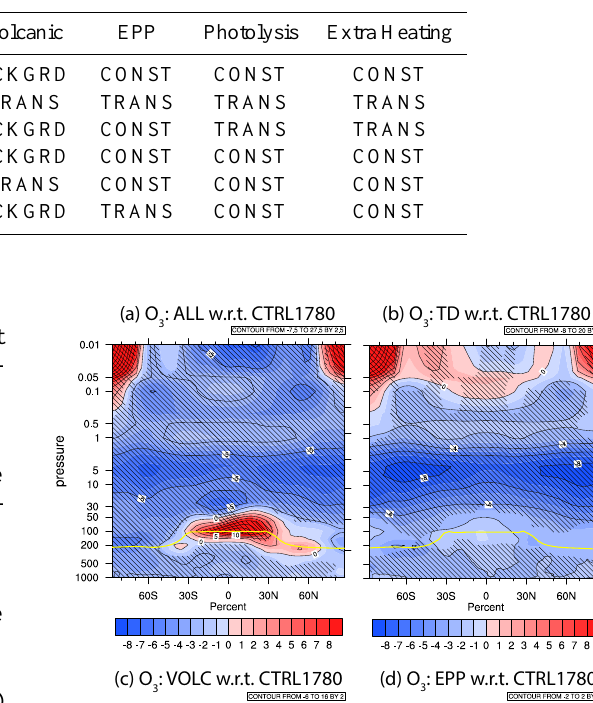
Table 1. Experiments for DM sensitivity runs: CONST values are monthly mean values from 1780. BCKGRD means that only background aerosol emissions were enabled and volcanic eruptions were turned off. TRANS means transient forcing.